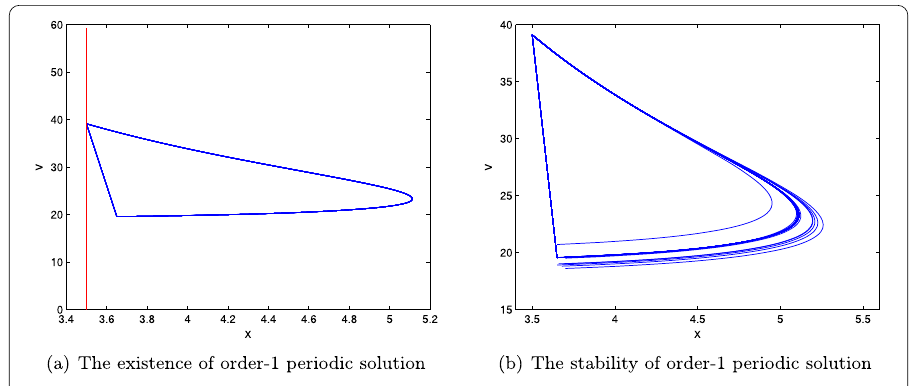
Figure 9 λ = 8, d = 0.4, β = 0.05, a = 0.1, q = 0.5 and x ∗ < h